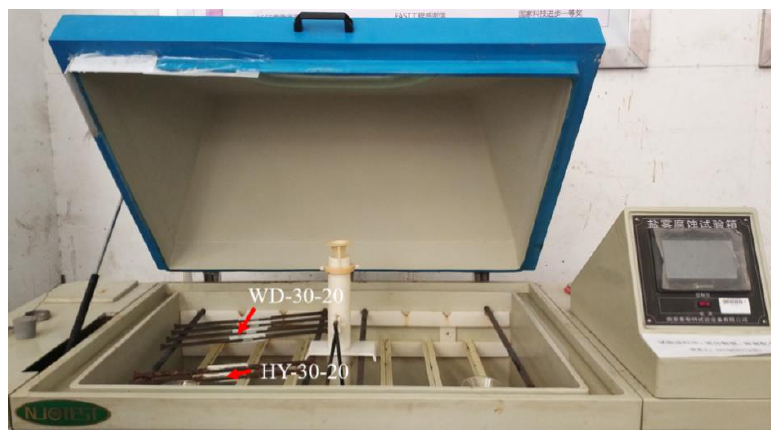
Figure 2. Environmental curing box.